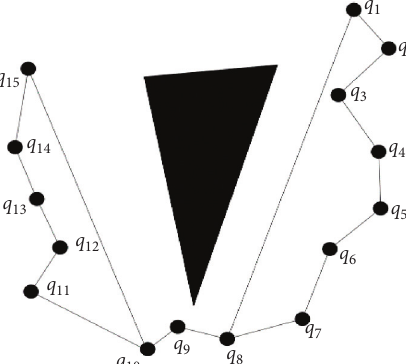
Figure 10: Pruning